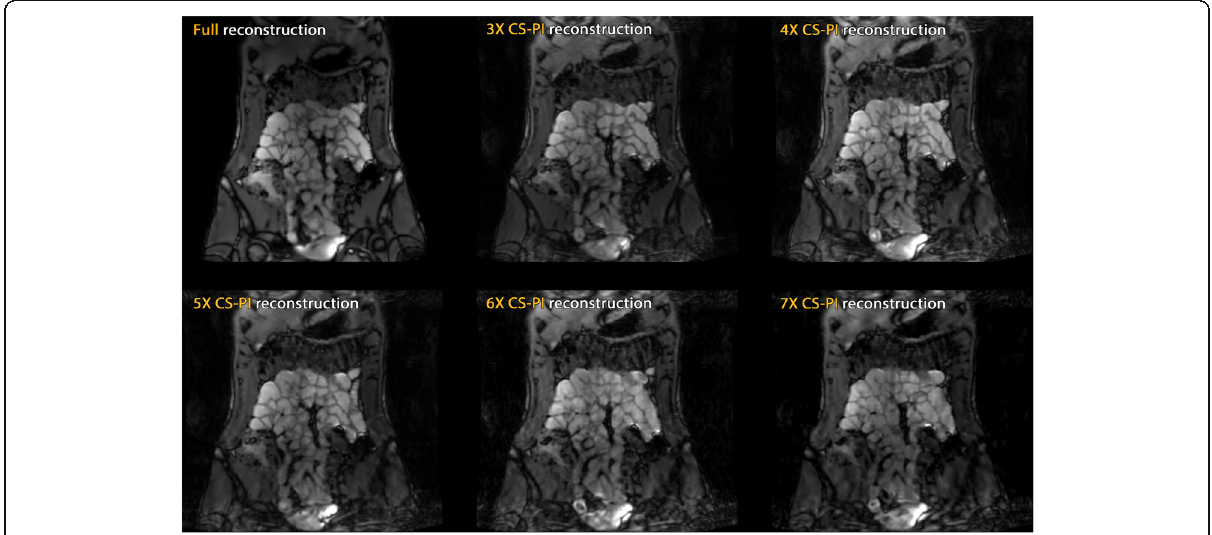
Fig. 2 Compressed sensing and parallel imaging (CS-PI) reconstructions from 3×, 4×, 5×, 6×, and 7× accelerated acquisitions (static